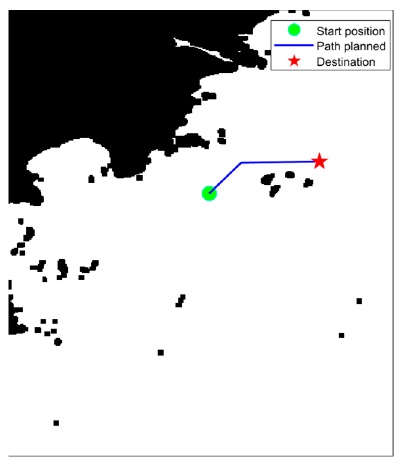
Figure 12. The path optimized by the Douglas–Peucker (DP) algorithm.